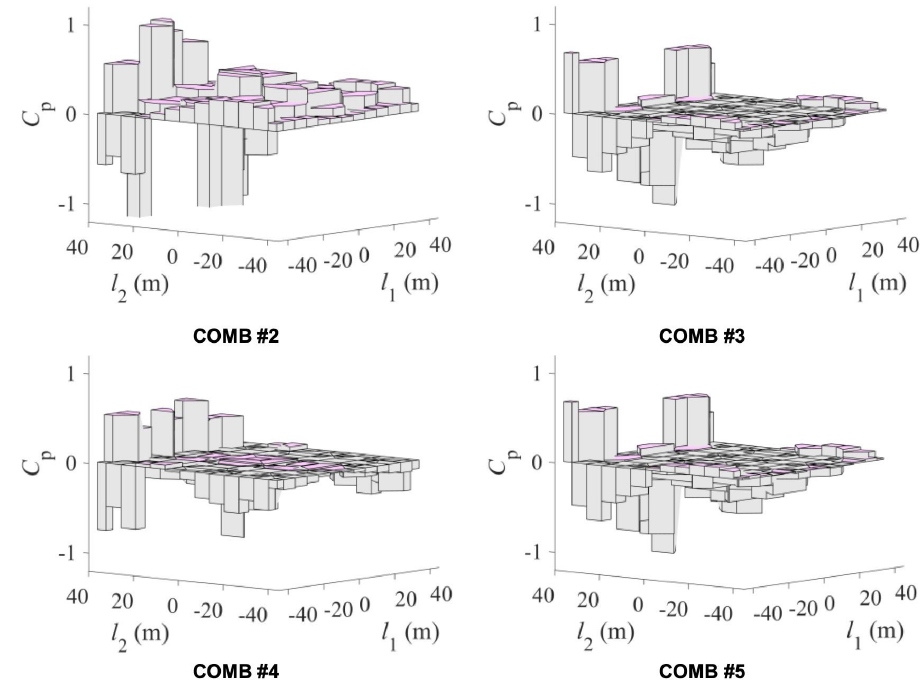
Figure 20: Examples of asymmetrical pressure coeflcient combination, C p , mean ν , for geometry G 1 and θ = 0 ∘